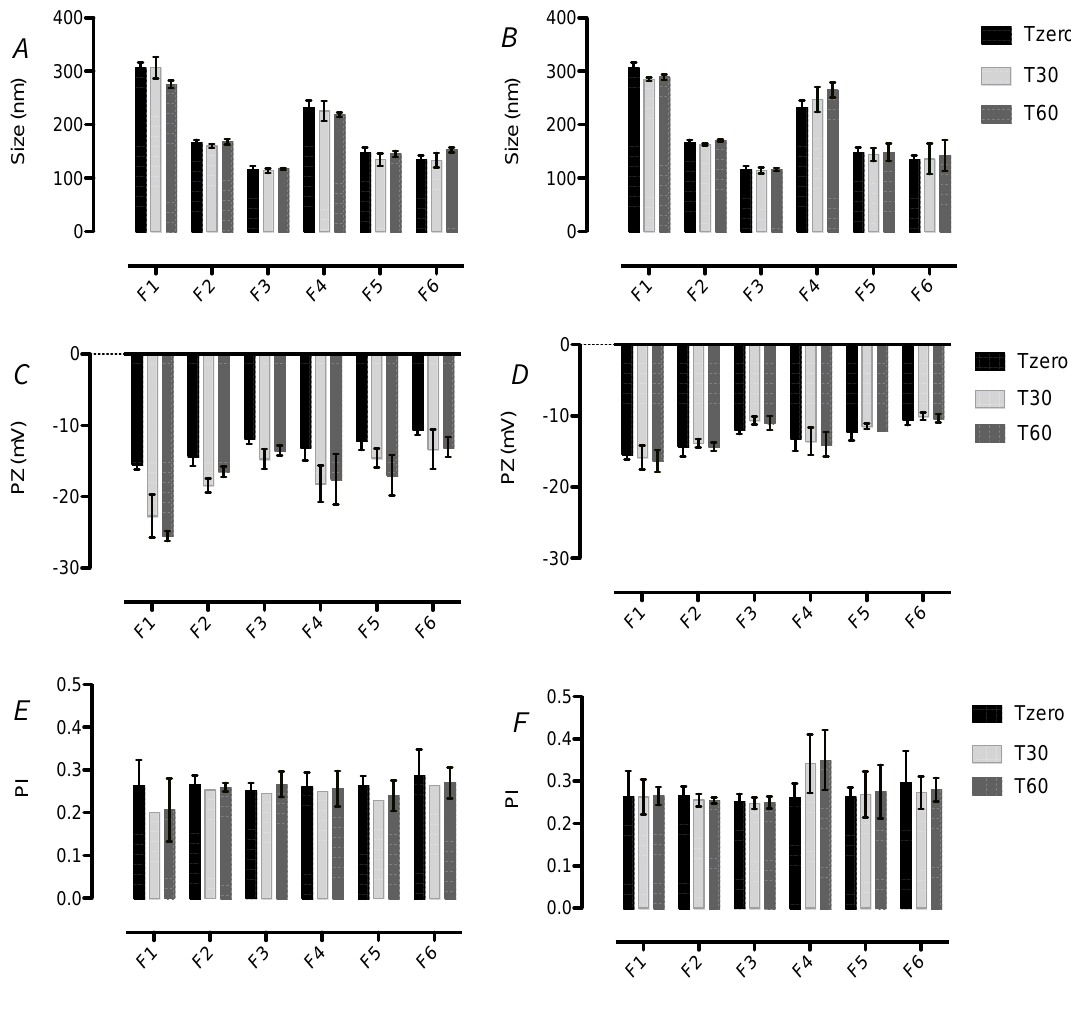
Figure 2. Stability of SLN upon storage. ( A ) Size of SLN F1-F6 over 60 days at 25 °C; ( B ) Size of F1-F6 SLN over 60 days at 4 °C; ( C ) Zeta potential of SLN F1-F6 over 60 days at 25 °C; ( D ) Zeta potential of SLN F1-F6 over 60 days at 4 °C; ( E ) PI of SLN F1-F6 over 60 days at 25 °C; ( F ) PI of F1-F6 SLN over 60 days at 4 °C.